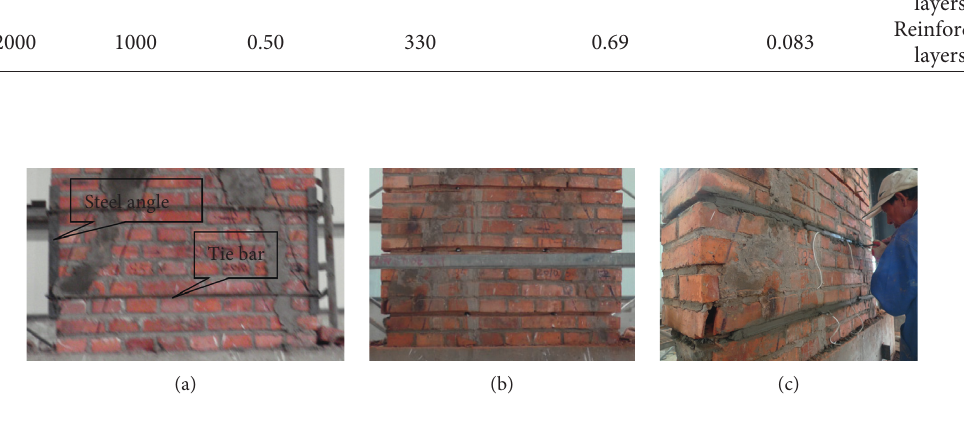
Figure 2: Reinforcing steps of damaged specimen. (a) Temporary constraints. (b) Slots on the specimen. (c) Embedding bar and pointing.